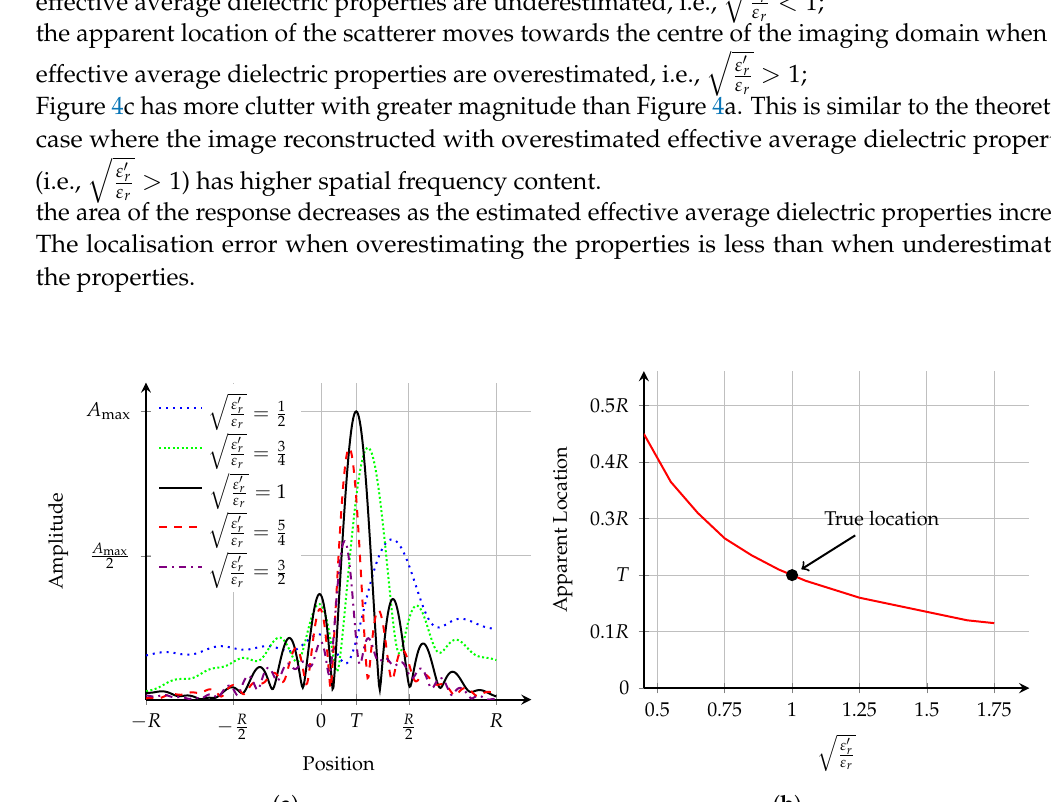
(cid:113) ε (cid:48) r > 1), the apparent ε r